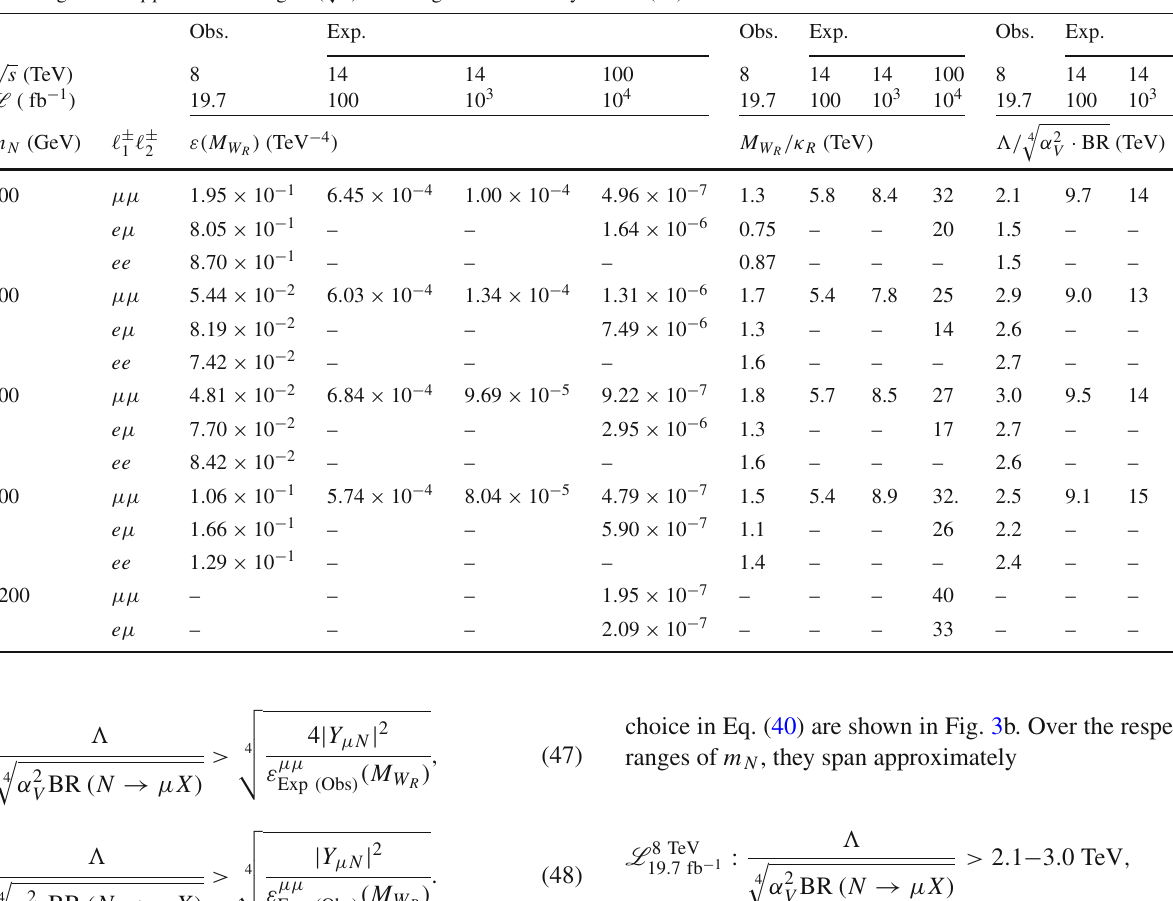
Fig. 3 a Observed and expected 95% CL s sensitivities to the ( M , m ) parameter space (κ W R N tionsviadirectandindirectsearchesinthe μ ± μ ± finalstate. b Observed Table 1 Observed [41,42] and expected [43] 95% CL s sensitivities to ε( M W assuming various pp collider energies (